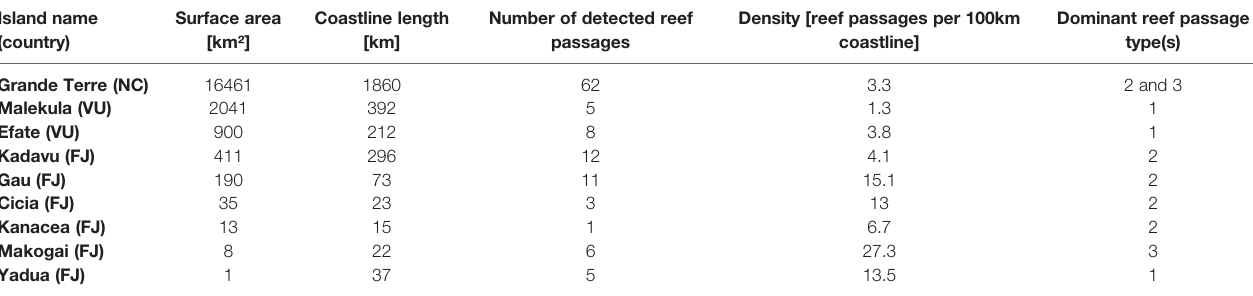
TABLE 1 | The nine study locations of this report, ranked by size (island surface area), with length of coastline, number of reef passages identi fi ed by visual interpretation of satellite imagery, density of reef passages per 100 km coastline, and dominant reef passage type(s); in New Caledonia (NC), Vanuatu (VU), and Fiji (FJ).